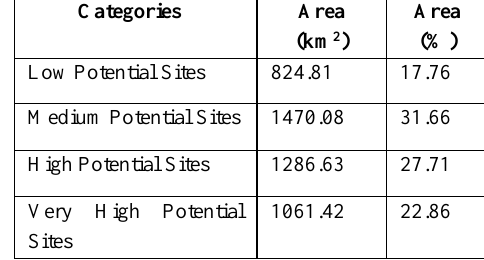
Figure 8 Potential Avalanche Formation zones Map Alaknanda Basin (ASTER) and avalanche site polygons overlaid after (B) and before (C) Mana Village Table 4 Category-wise area distribution of avalanche